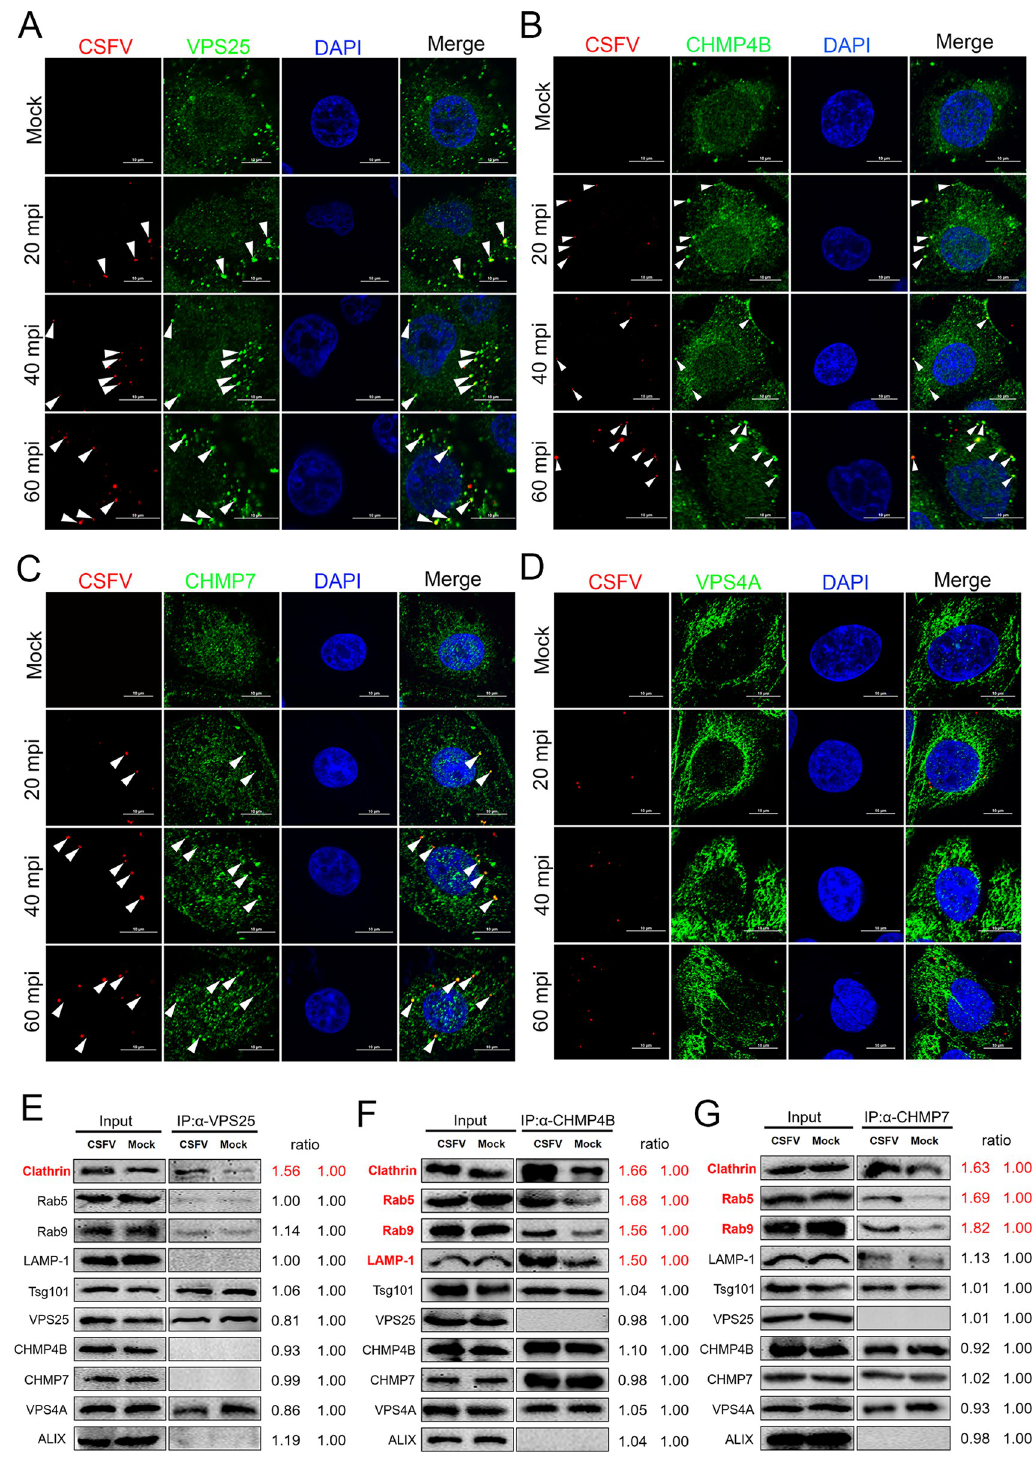
Fig 2. ESCRTs machinery participates in CSFV endocytosis. (A-D) PK-15 cells were infected with CSFV (MOI = 10) at 4˚C for 1 hpi, then shifted to 37˚C for indicated time points, respectively. After fixed and subjected to immunofluorescent by using mouse anti-CSFV E2 monoclonal antibody (WH303) and rabbit anti-VPS25 (A); -CHMP4B (B); -CHMP7 (C); -VPS4A (D) antibody. The nuclei were stained with DAPI. The white arrow indicates the co-localized protein. Bars = 10 μ m. These data are representative of three independent experiments. (E-G) PK-15 cells were infected with CSFV (MOI = 10) or not for 6 hpi,